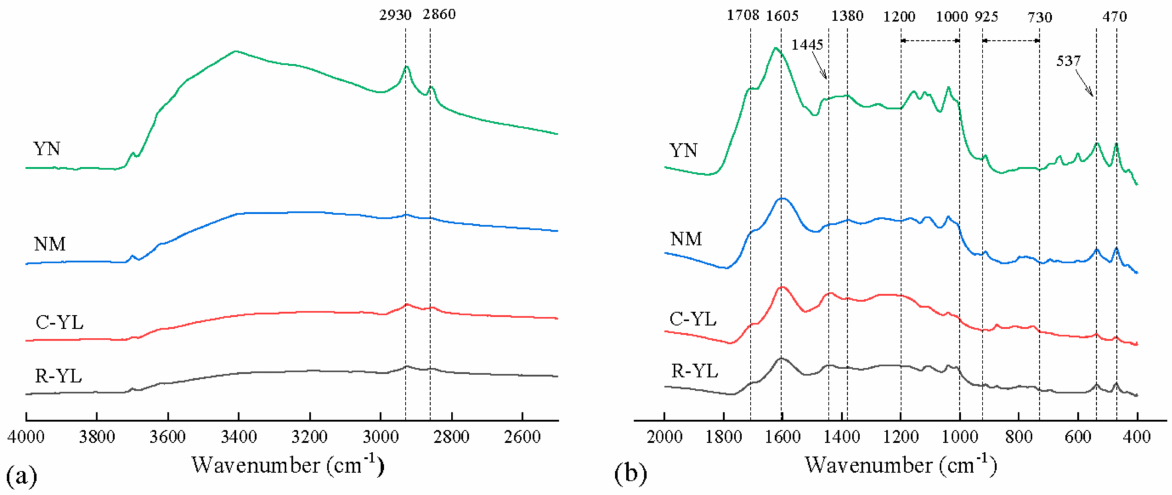
Figure 3. DRIFT spectra of R-YL, C-YL, NM and YN coals, ( a ) 2600–4000 cm − 1 , ( b ) 400–2000 cm − 1